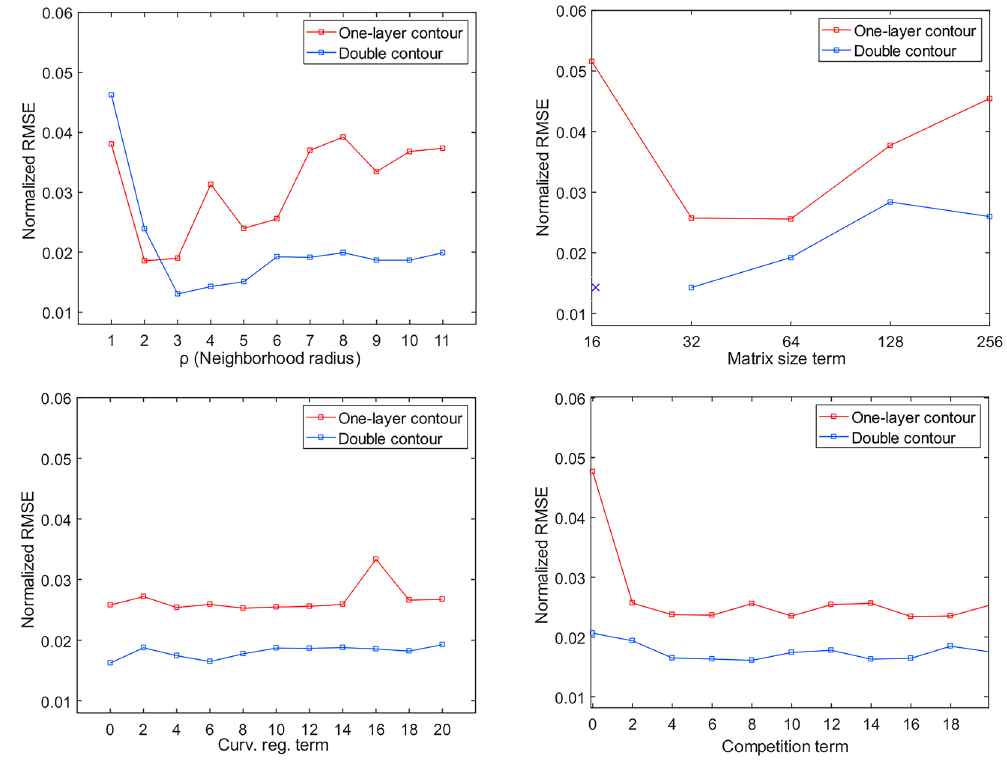
Figure 5. Parameter sensitivity analysis: comparison between one-layer vs. double contours where the Y-axis is the normalized RMSE of the extracted signals compared to the raw signals: (top left) effect of radius length values on segmentation sensitivity, double contour segmentation has less segmentation error for all values in the relevant range > 3. (top right) effect of the number of contour nodes: higher RMSE for one-layer segmentation for all values, note the segmentation failure of double contour method at low (e.g. sixteen) contour nodes number, as indicated with x. Curve regulation term (bottom left). Competition term (bottom right): lack of competition term causes high normalized-RMSE for one-layer